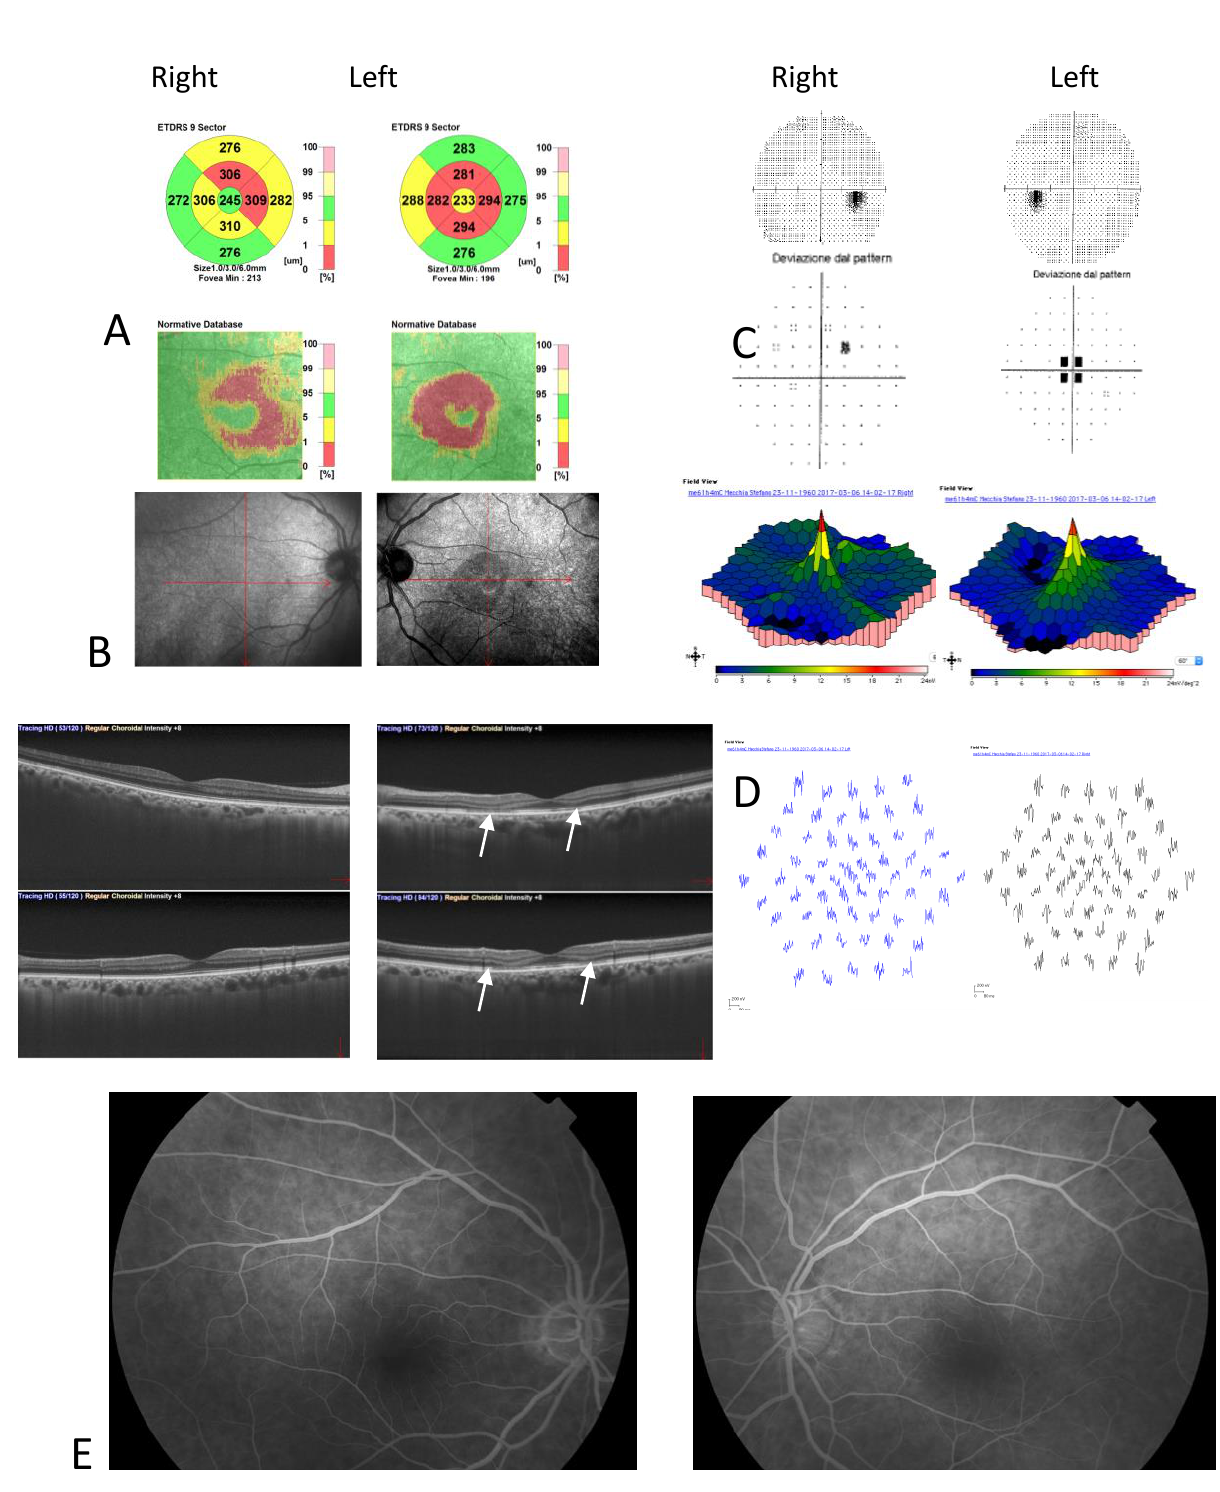
Figure 2. ( A ) Optical coherence tomography (OCT) Thickness Maps show a reduction of perifoveal macular thickness greater in the left eye; ( B ) OCT retinal segmentation analysis showed preserved retinal layers in the right eye and thinning of the outer nuclear layer in the left eye (arrows); ( C ) Humphrey’s visual field 30–2 total deviation map revealed central scotoma in the left eye; ( D ) Multifocal electroretinogram showed blunted foveal peak in the left eye. The voltage of the first positive wave (P1) was decreased in the temporal macula; (E) Fluorescein angiography was normal in both eyes. After six months of Tacrolimus suspension, the left eye BCVA improved to 20/25,